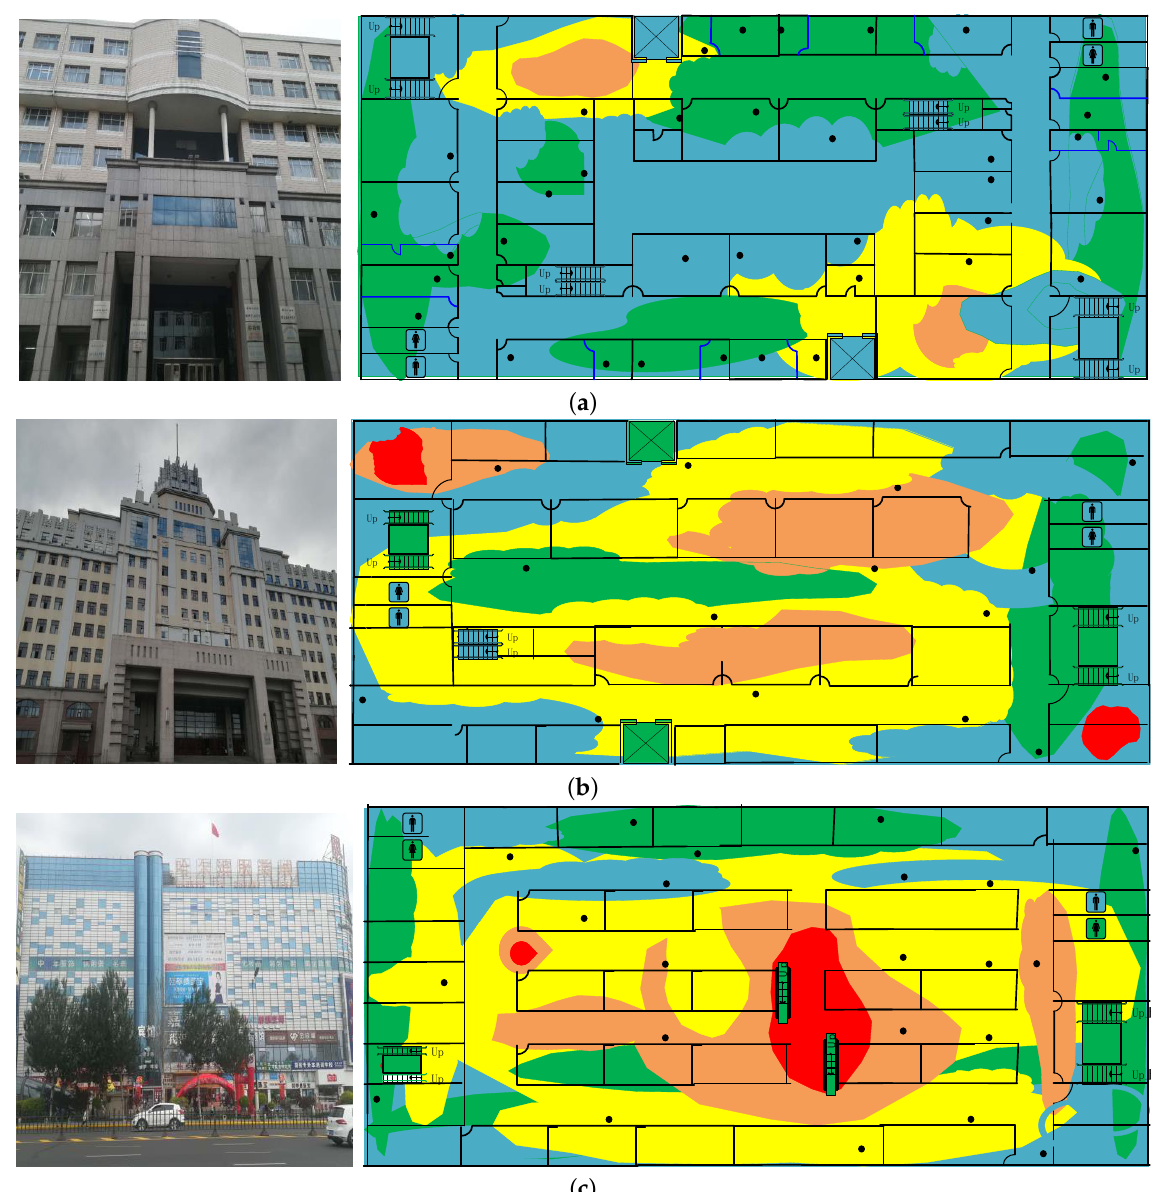
distribution, and Huiwen building has the lowest APs distribution.